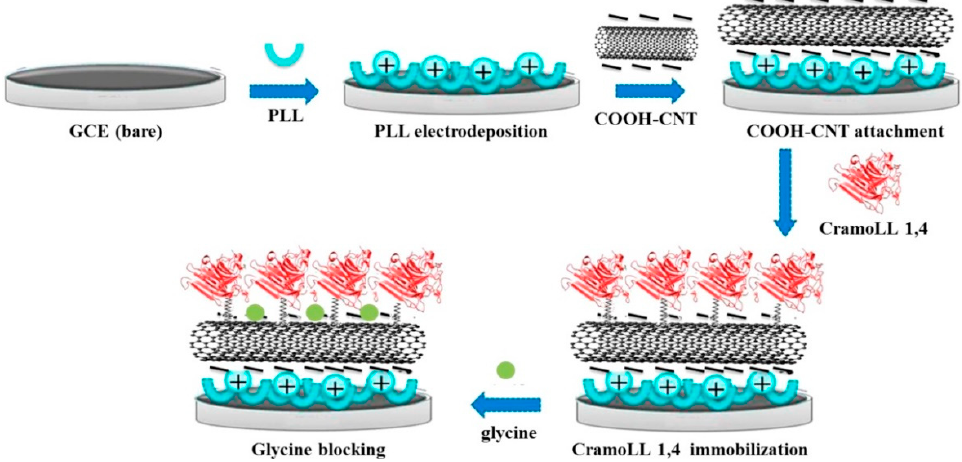
Figure 12. Schematic illustration of the stepwise modification of the lectin-based nanobiosensor. Reprinted from ref. [191]. Copyright (2016) with permission from Elsevier.